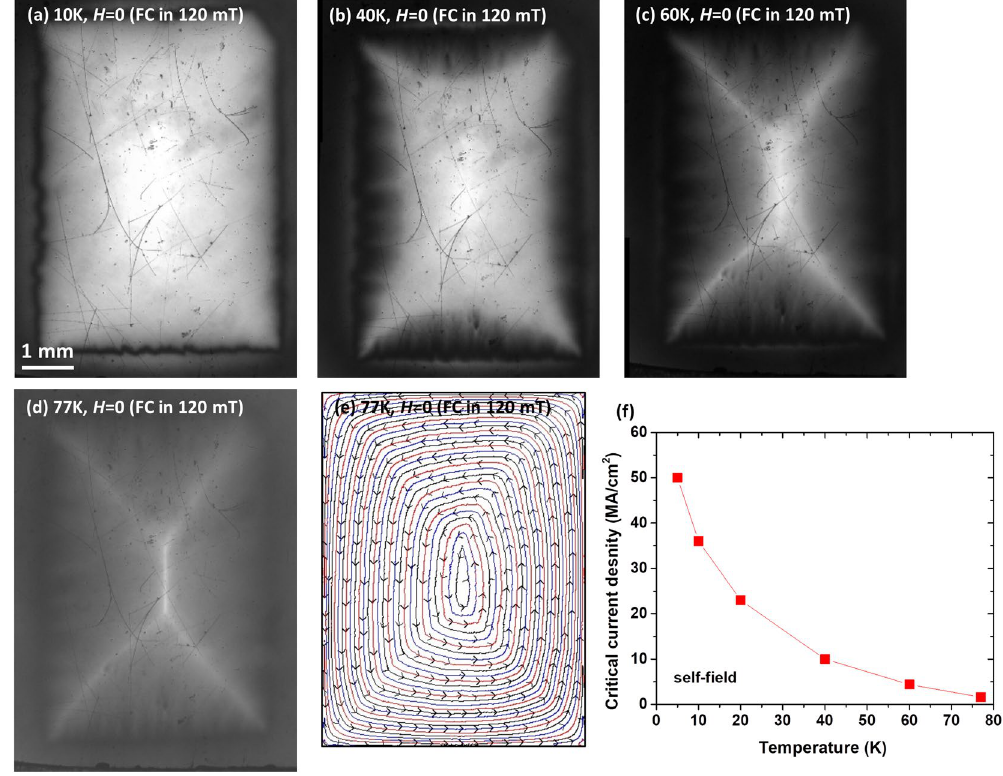
Figure 3. Magneto-optical microscope of the local trapped field after the sample cooled from room temperature in a 120 mT background field to ( a ) 10 K, ( b ) 40 K, ( c ) 60 K, and ( d ) 77 K. ( e ) Current stream lines calculated for ( d ) that illustrates the uniform current distribution in the film. ( f ) is the calculated J c from the penetrated magnetic field after zero-field cooling according to Bean model. ( a ) to ( e ), especially the “rooftop” pattern in ( d ) suggest the electromagnetic homogeneity of the film. For all images, the brighter areas correspond to high trapped magnetic field regions.